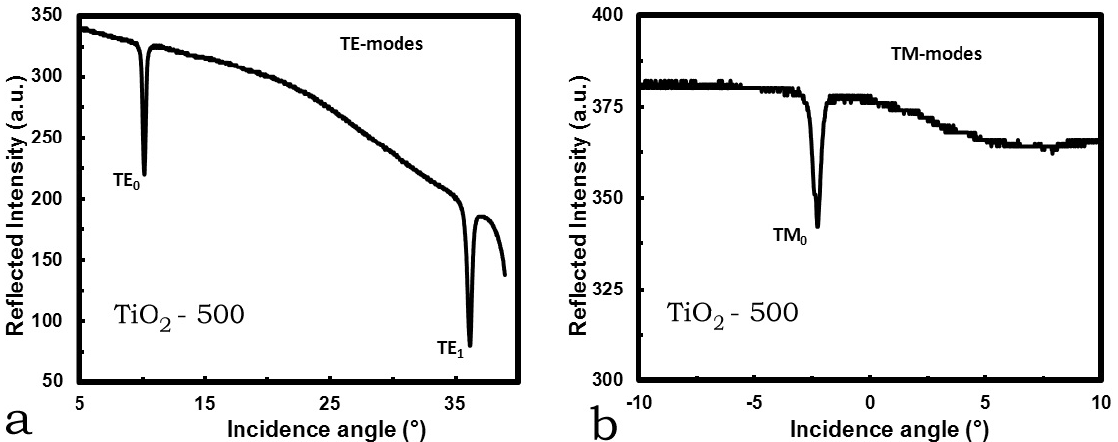
-500 thin film: ( a ) TE and ( b ) TM 2